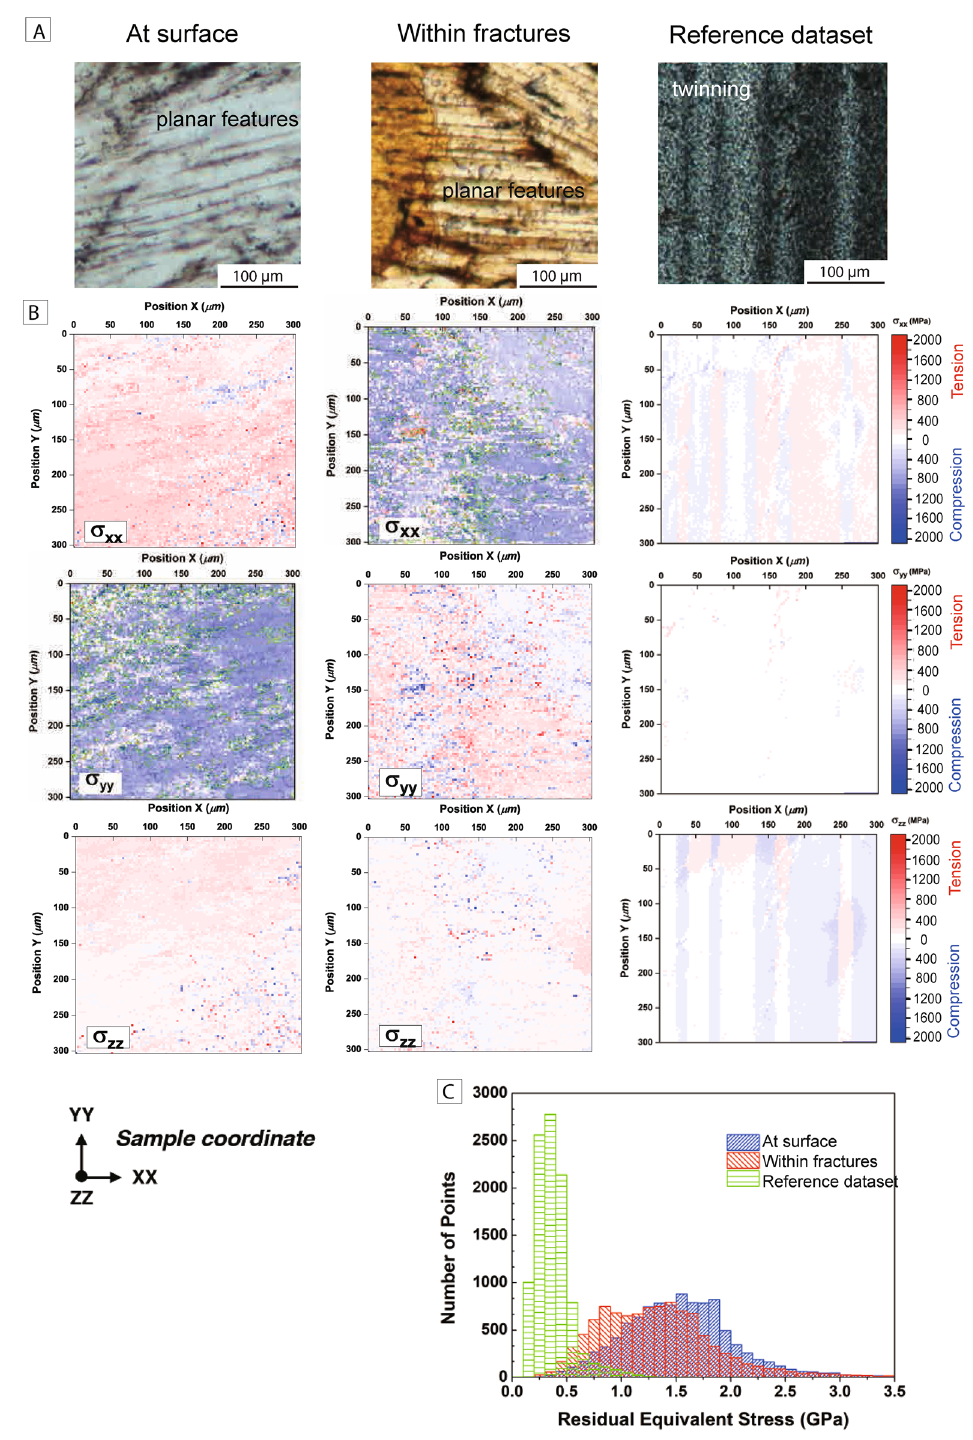
Figure 7. Residual stress mapping and the statistics of residual stress in K-feldspar and plagioclase from the two fulgurites and the reference sample (from a depth of 138 m). (A) Optical microscope images (plane polarized light images for two fulgurites and cross polarized image for granitic gneiss reference dataset) show planar features (exsolution lamellae) in K-felspar and twinning in plagioclase, respectively. (B) Distribution and magnitudes of axial stresses σ xx , σ yy , and σ zz in K-feldspar and plagioclase. The gigapascal-scale residual deviatoric stress was determined with some exceptions that were higher than 2 GPa (green-circled area) within the K-feldspar from the two fulgurites. Plagioclase containing residual stress values of 0.38 ± 0.13 MPa on average in different stress direction and parallel to the intrinsic twining. (C) Statistics of residual stresses from the two fulgurites and the reference